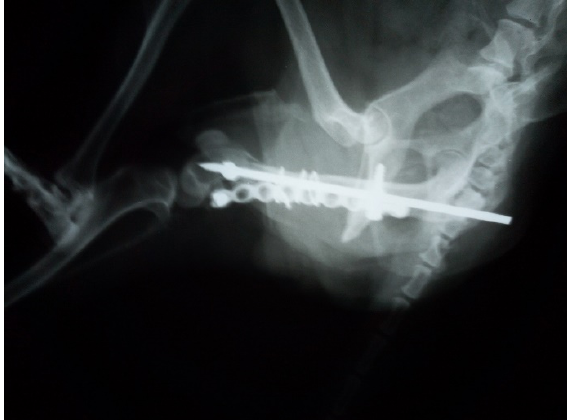
Fig. 15. Radiography in old dog showed primary bone heal- ing after 30 days of operation In young dog, a dog was removed external acrylic bar from left humerus after 1month of operation and a young dog could be walk and run without stiffness after 2 months of operation. The bone healing was secondary bone healing in all 3 long bones (Fig. 16).